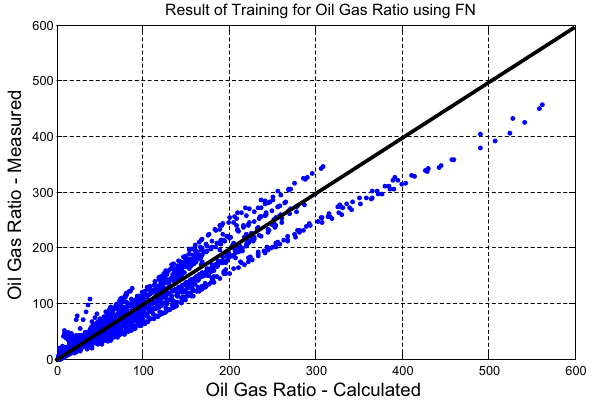
Fig. 9 Cross-plot of R v using FN for training